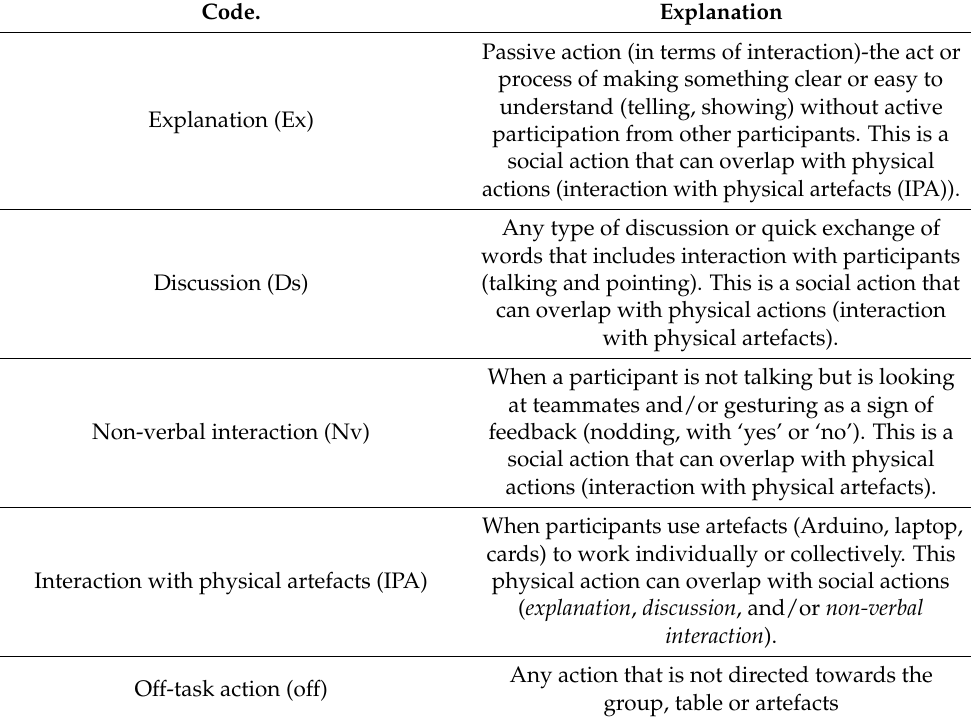
Table 1. Coding schema for the analysis of student actions with